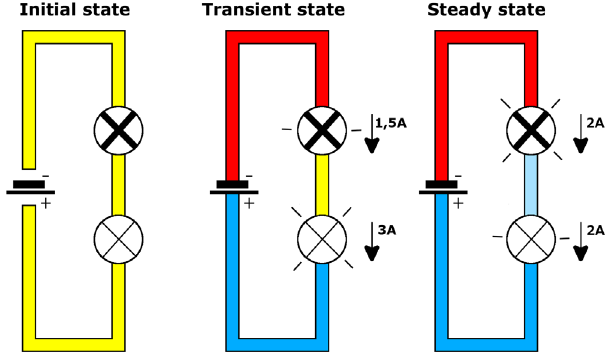
12. Analysis of a series circuit using a dynamic mental model. Red stands for high electric pressure, blue for low electric pressure and yellow for normal electric pressure. Light blue stands for an electric pressure slightly lower than normal electric pressure. The upper light bulb with thicker lines has twice the resistance compared to the lower one. The arrows refer to the direction of electron